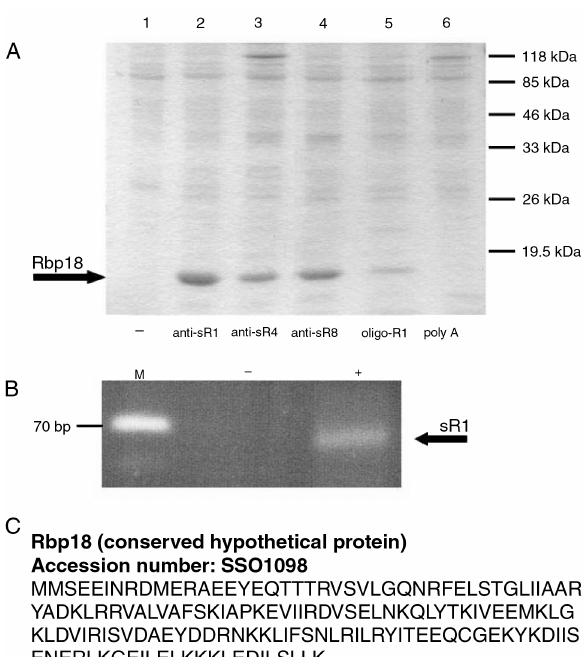
Figure 1. Isolation of Rbp18 from Sulfolobus solfataricus cell lysates. (A) Proteins isolated from S. solfataricus lysates by the bioseparation technique, resolved by SDS-PAGE and stained with Coomassie blue. Each lane contains the proteins recovered after bioseparation using the indicated anti C/D box sRNAs (anti-sR1, anti-sR4 and anti-sR8), an oligonucleotide with limited specificity (oligo-R1) and a nonspe- cific oligonucleotide (poly A). The numbers on the right indicate the positions of the molecular mass markers. (B) Products of RT-PCR re- actions performed on the material recovered from a bioseparation with the anti-sR1 oligonucleotide (from Lane 2 of (A)). Abbrevia- tions: M = molecular mass marker; (–) = negative control (no proteins added); and (+) = addition of anti-sR1 isolated material. (C) The Accession number and amino acid sequence of